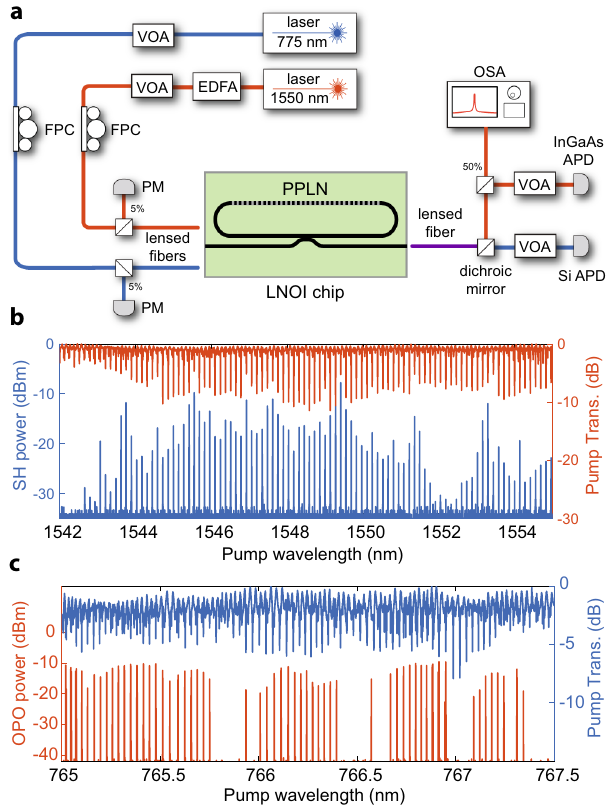
Fig. 2 Characterization of nonlinear devices. a Experimental setup. We couple light at around 775 or 1550 nm wavelengths onto the chip by aligning a lensed fi ber to a cleaved edge facet to excite the coupling waveguide. Light is outcoupled from the chip and demultiplexed to detect the fundamental and second harmonic light separately. b Scanning the near-infrared laser shows that second-harmonic generation occurs at wavelengths corresponding to modes of the resonator. c Scanning the blue pump laser across wavelength shows that many resonances surpass the parametric oscillation threshold. VOA variable optical attenuator, EDFA erbium-doped fi ber ampli fi er, FPC fi ber polarization controller, PM power meter, OSA optical spectrum analyzer, APD avalanche